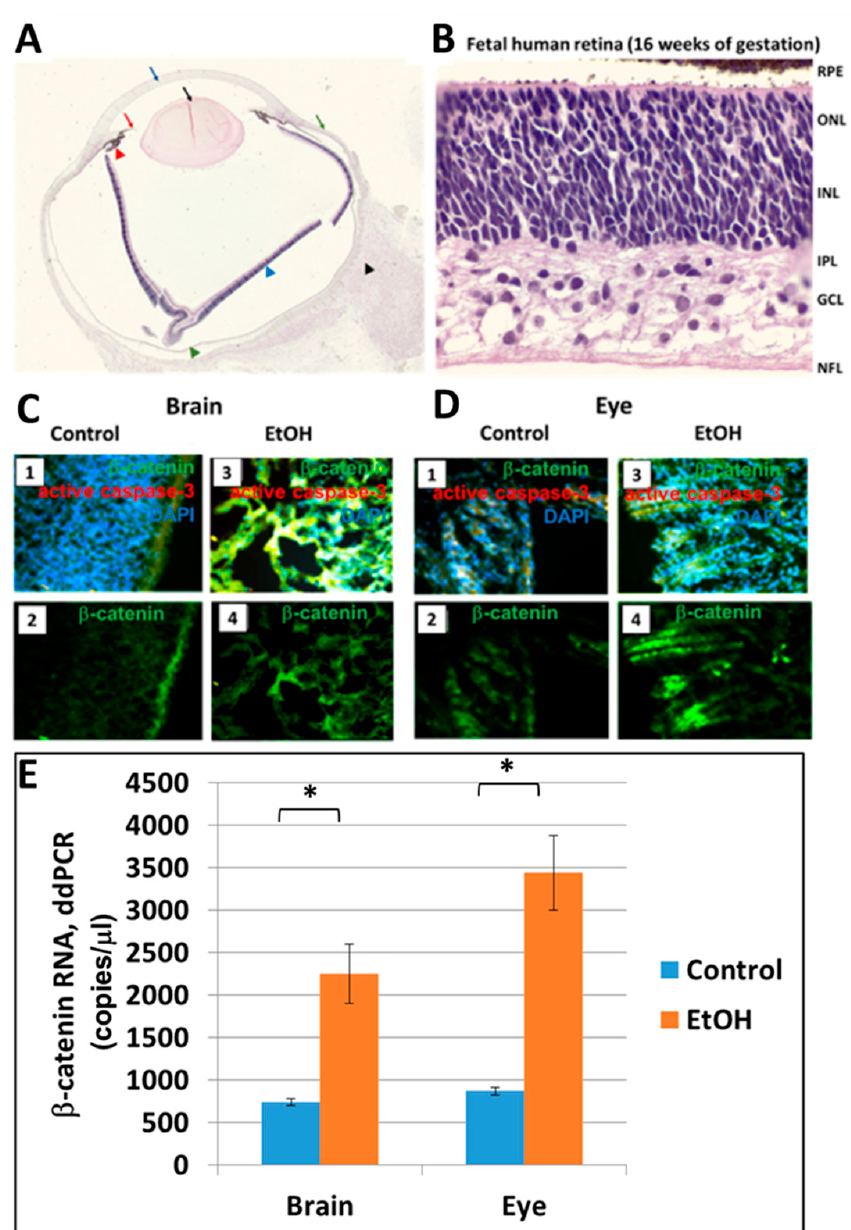
Figure 5. Prenatal EtOH exposure upregulates β -catenin in fetal brain and eye in EtOH-exposed fetuses compared to matched unexposed controls. ( A ) Fetal eye globe (16 weeks GA) in sagittal section: the cornea (cyan arrow), iris (red arrow), lens (black solid arrow), and ciliary body (red arrowhead) can be identified. The anterior chamber is the space between the anterior iris and posterior cornea, and the posterior chamber is comprised of the space between the vitreous and the posterior aspect of the iris. In the field of the posterior globe, the head of the optic nerve (black arrowhead), the retinal pigment epithelium (RPE) (green arrowhead), retina (cyan arrowhead), and the sclera (green arrow) can be identified. ( B ) Fetal human retina (16 weeks GA). Hematoxylin and eosin staining. RPE = retinal pigment epithelium; ONL = outer nuclear layer, containing the nuclei of the future photoreceptors (the photoreceptor outer segments do not yet exist); INL = inner nuclear layer, containing nuclei of the Müller cells, and the where the horizontal, bipolar and amacrine cell bodies will be; IPA = inner plexiform layer; GCL = ganglion cell layer; NFL = nerve fibre layer. ( C ) Effect of EtOH exposure on β -catenin in fetal brain. Brain sections were collected and prepared from EtOH-exposed 2nd trimester fetuses and unexposed 2nd trimester controls, and stained with DAPI (blue) and caspase-3 (red) (panels 1 and 3). Panels 2 and 4 show staining for β -catenin only (green). ( D ) Effect of EtOH exposure on β -catenin in fetal eye. Panels 1 and 3: β -catenin and DAPI staining. Brain and eye sections were prepared from EtOH-exposed 2nd trimester fetuses and stained with DAPI (blue, which appears as cyan because of overlap with green) and activated caspase-3 (red which appears as yellow because of overlap with green, or as magenta because of overlap with blue, or as light yellow because of overlap with blue and green). Panels 2 and 4, β -catenin (green). ( E ) EtOH-induced upregulation of β -catenin mRNA expression in 2nd trimester human fetal brain and eye. Absolute quantitation of β -catenin mRNA (copies/ μ L) was obtained by ddPCR for 10 EtOH- exposed and 10 age- and sex-matched control brains and eyes. Each assay was performed in triplicate and averaged for each fetus. Error bars are SD among the averaged values for the fetuses. * p < 0.05 ( p = 0.02).